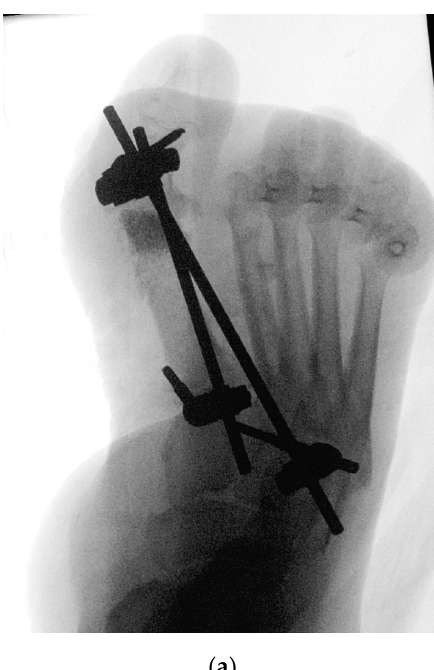
Figure 1. ( a ) Intraoperative X-ray—resection of 1st metatarsophalangeal joint, placement of bioactive glass granules, and placement of external fixation device. Image captured intraoperatively with diascopy using Siemens Cios Alpha ® (Siemens, Munich, Germany) (average exposition parameters: 50 kV, 0.05 mAs, and 5 fps); ( b ) patient three months after resection of 1st metatarsophalangeal joint and bioactive glass insertion. Image captured with Philips Digital Diagnost ® (Philips, Amsterdam, The Netherlands) (exposure parameters: 70 kV and 2 mAs).